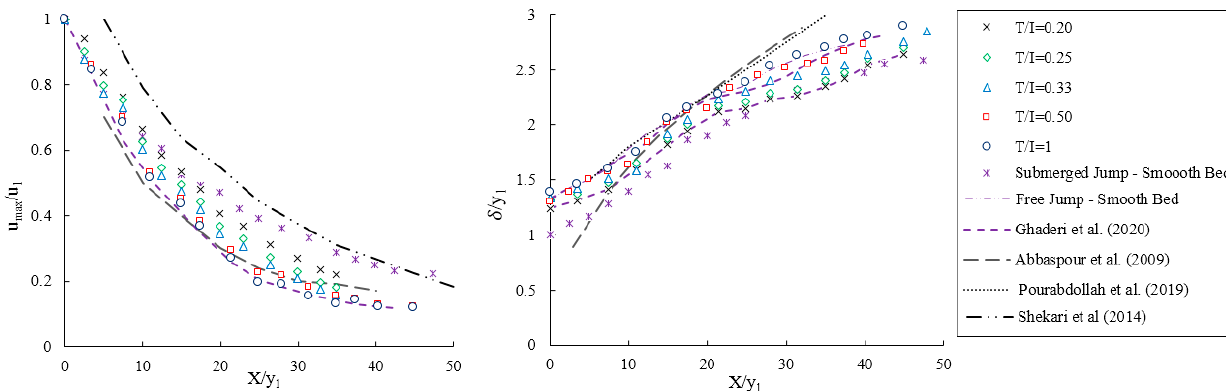
Figure 15. Spatial variations of ( u max /u 1 ) and ( δ ⁄ y 1 ).